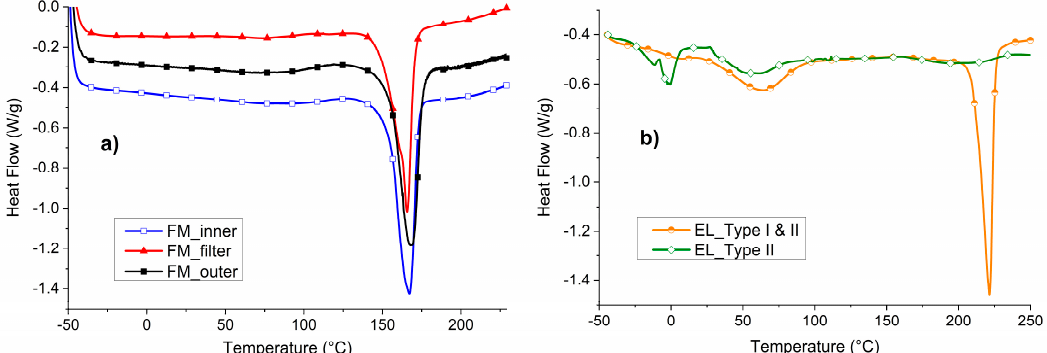
Figure 5. Differential Scanning Calorimetry (DSC) of: ( a ) MCA FM parts and ( b ) EL parts. Figure 5. Di ff erential Scanning Calorimetry (DSC) of: ( a ) MCA FM parts and ( b ) EL